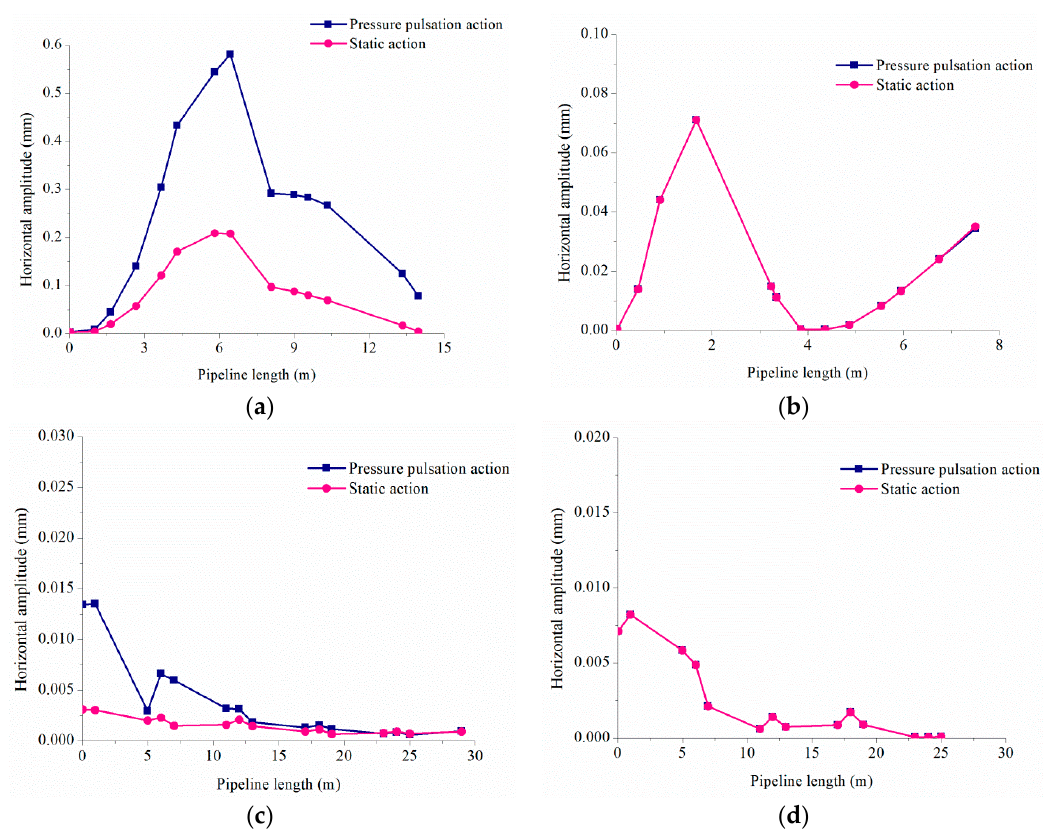
Figure 20. Horizontal amplitude of pipes: ( a ) RP1 pump outlet pipe; ( b ) RP1 pump inlet pipe; ( c ) main outlet pipe; ( d ) main inlet pipe.